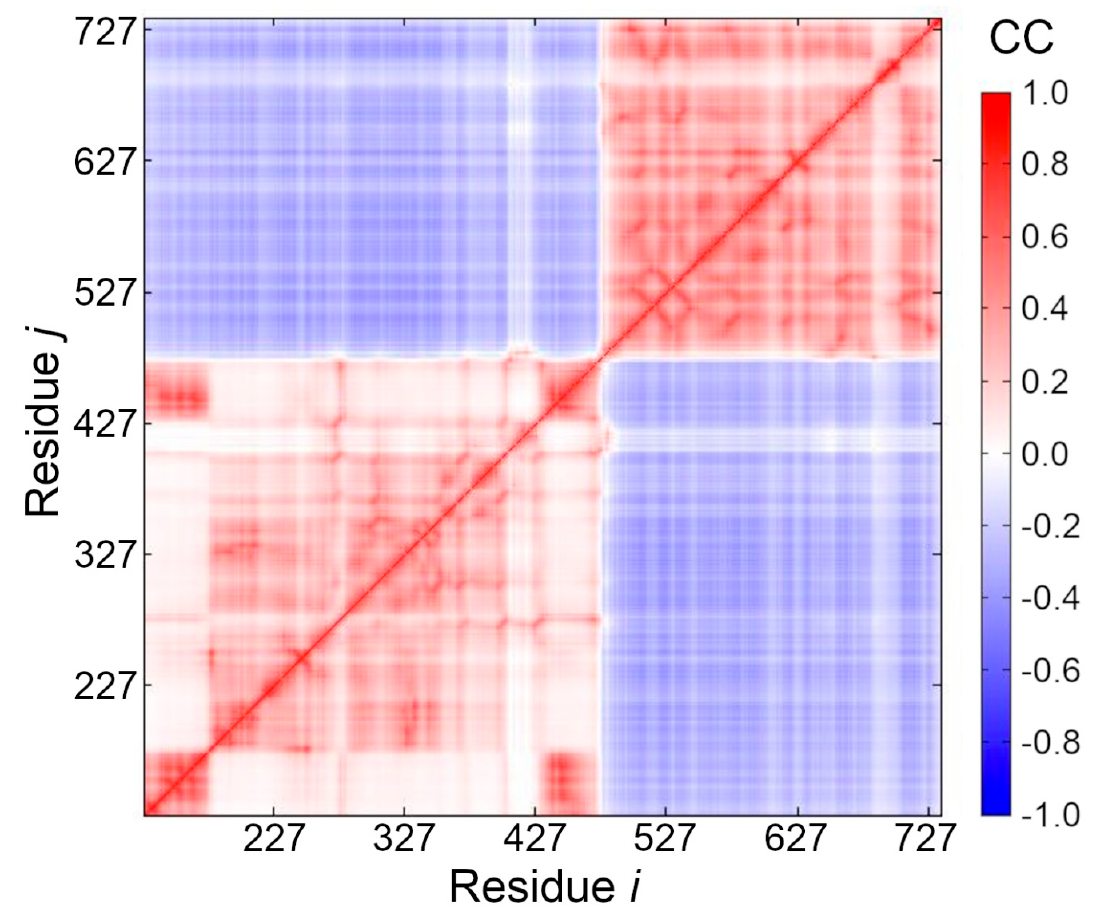
Figure 5. Orientational cross-correlations between residue fluctuations. The cross-correlation (CC) map shows the extent of correlation of the movements between two nodes, i and j , representing amino acid residues. CC values vary from − 1 (fully anticorrelated motions, blue) to + 1 (fully correlated motions, red).